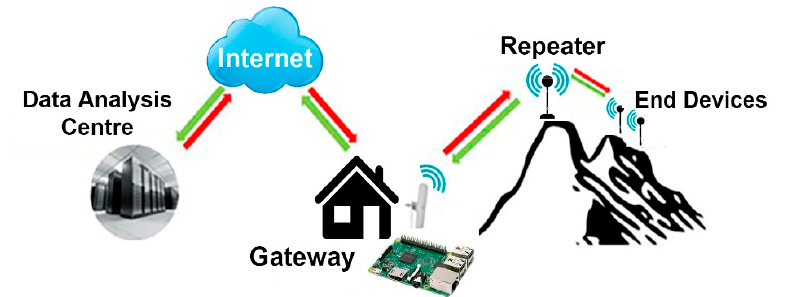
Figure 2. Network operation scheme.